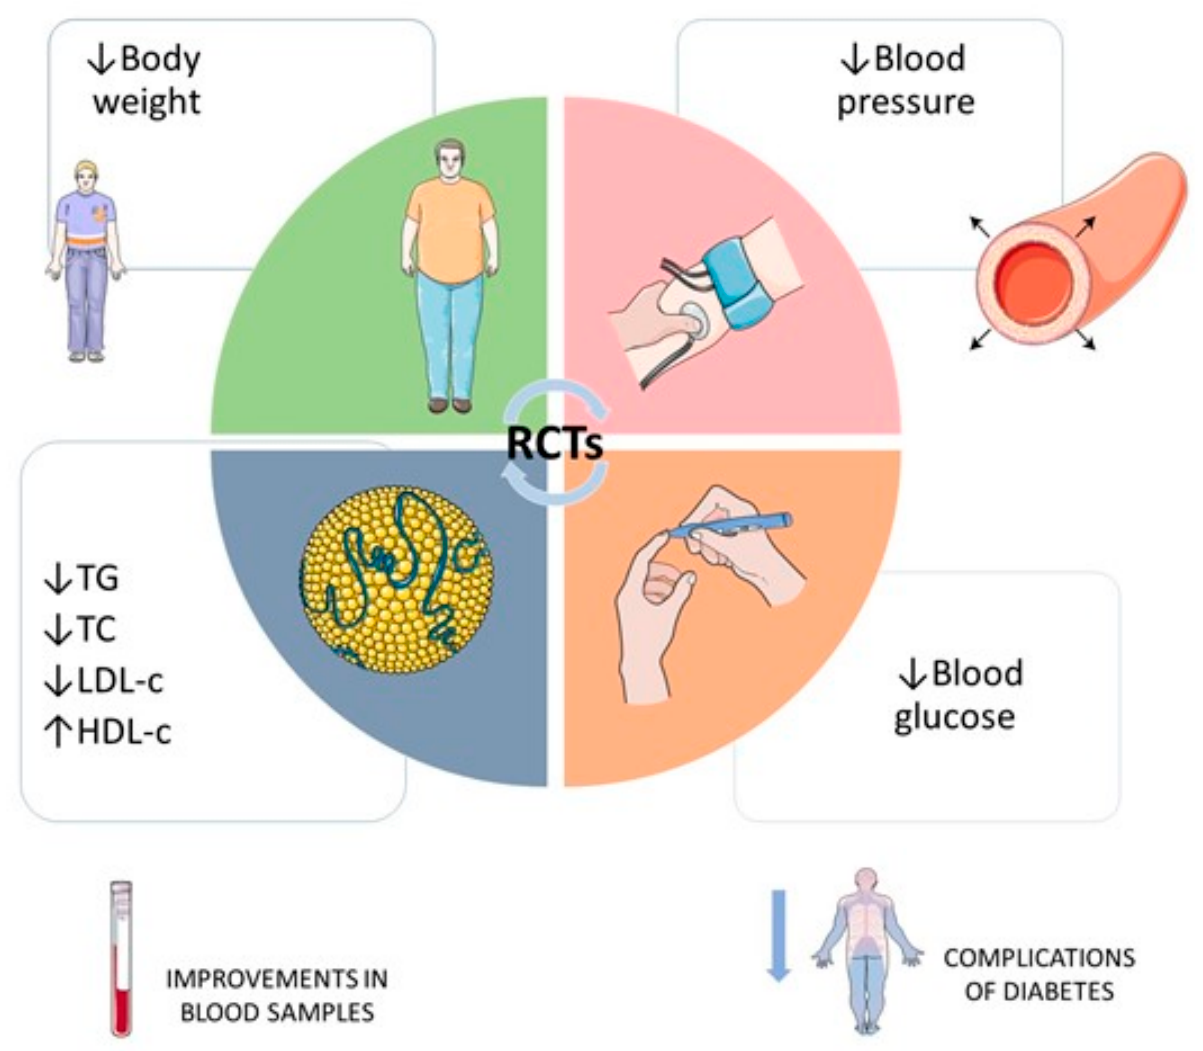
Figure 3. Pertinent findings of the included randomized clinical trials. ↑ , increase; ↓ , decrease; HDL-c, high-density lipoprotein cholesterol; LDL-c, low-density lipoprotein cholesterol; RCTs, randomized clinical trials; TC, total cholesterol; TG, triglycerides.